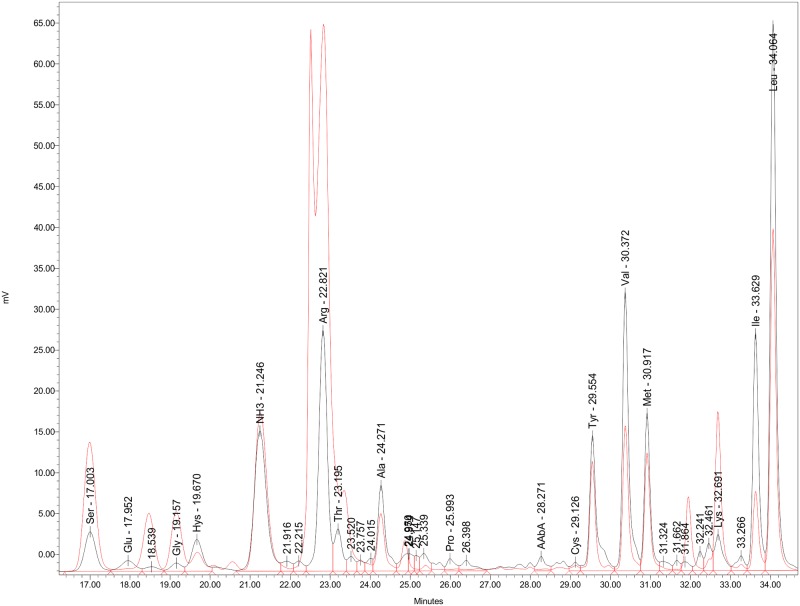
Comparison of amino acid profiles of the paralyzing fractions of Octopus maya.Amino acid profile of the paralyzing fraction from posterior salivary glands (PSG; pink) provided by fishers matched the paralyzing fraction from saliva in vivo (black). Eleven of the amino acids from the saliva are present in PSG aminogram in nearly the same amounts. Detection with Waters 2470 fluorescence detector, conditions: excitation wavelength: 250 nm, emission wavelength 395 nm [29].